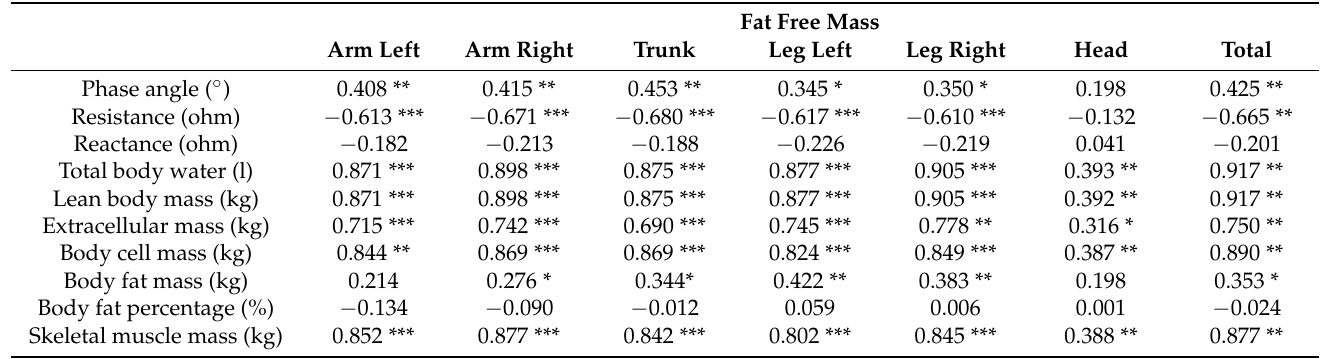
Table 3. Correlation coefficients between the bioelectrical impedance analysis and